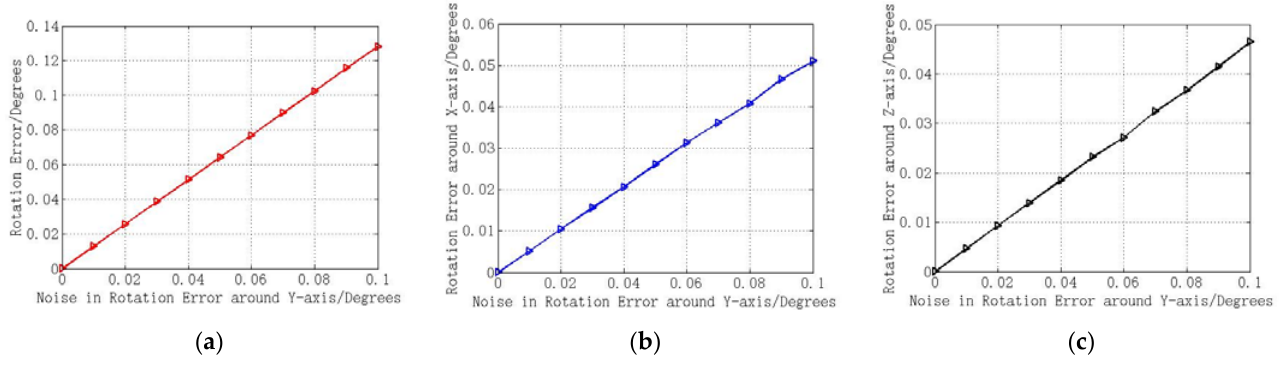
Figure 3. Robustness to roll angle noise: ( a ) the total rotation error; ( b ) the rotation error around the X ‐ axis; ( c ) the rotation error around the Z ‐ axis.